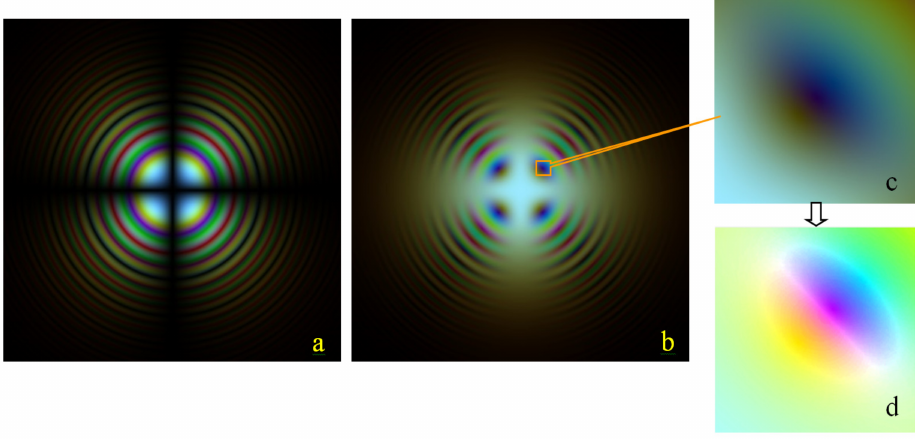
Figure 7. The distribution of light in crossed ( a ) and parallel ( b ) polarizers when a uniaxial crystal of lithium niobate with a length z = 100 mm is between them w 0 = 5 mkm, size 4 w ; neighborhood of the “colored” vortex ( c ) and its chromatoscopy ( d